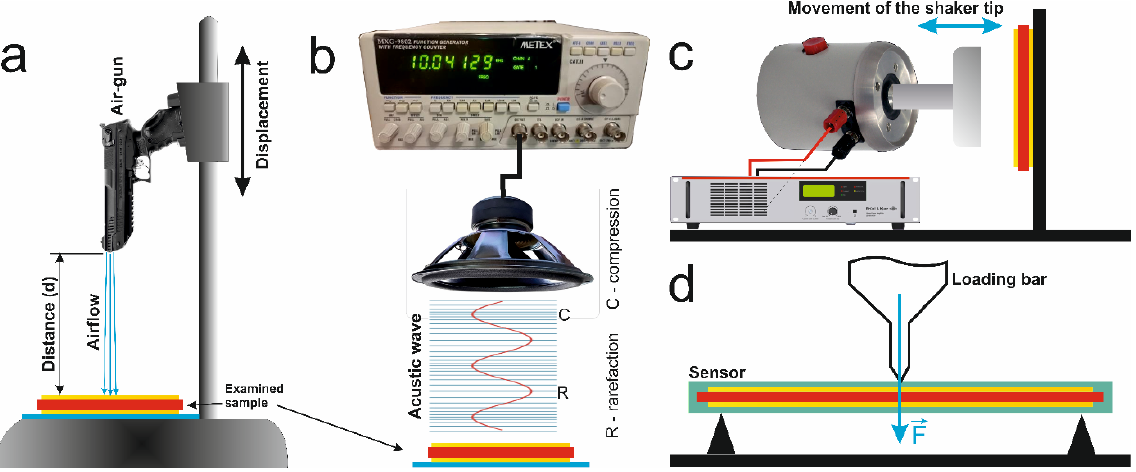
Figure 10. Diagrams showing various experimental set-ups that can be used for measuring the electrical response of the nanogenerators under the influence of ( a ) a shock wave, ( b ) an acoustic wave, and ( c ) an impact. ( d ) Scheme of a stand for measuring the piezoelectric response of the sensors for different applied loads.